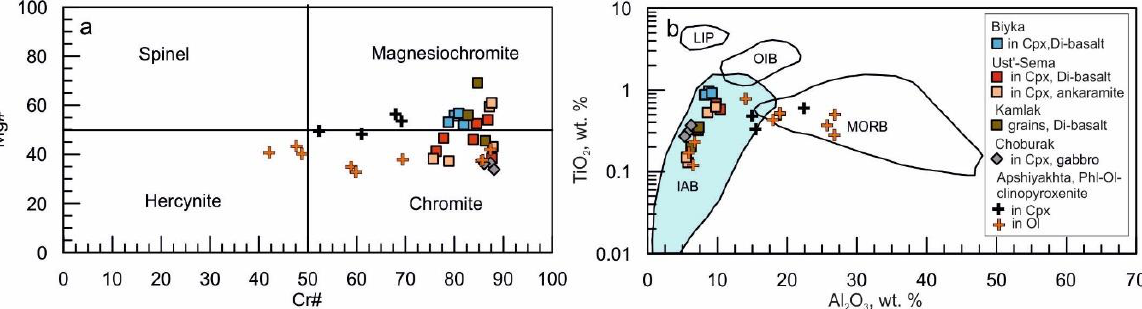
Figure 8. ( a ) Classification diagram for spinels [29]; ( b ) Al 2 O 3 versus TiO 2 discrimination diagram for spinels from different tectonic settings [30]. IABs — island-arc basalts; OIBs — ocean island basalts; MORBs — mid-ocean ridge basalts; LIPs — basalts of large igneous provinces. Cr-spinel from Apshiyakhta phlogopite – olivine clinopyroxenite had a diverse com- position and was represented by chromite, magnesiochromite, and hercynite (Figure 8a). Inclusions of Cr-spinel in clinopyroxenes in these rocks had a relatively low Cr# 52.3 – 69.2 and a high Mg# 48.3 – 56.4 versus Cr# 42.1 – 87.4 and Mg# 32.8 – 43.4 for inclusions in olivine (Table 5). The TiO 2 content of Cr-spinel inclusions varied from 0.33 – 0.60 wt.% in clinopy- roxenes to 0.12 – 0.78 wt.% in olivine (Table 5). The Al 2 O 3 content reached up to 26.81 wt.% (Figure 8b; Table 5). The points of the Cr-spinel compositions from the volcanic rocks of the Ust’ -Sema Formation and the Choburak gabbro fall into the field of island arc systems, whereas the Cr-spinel from phlogopite – olivine clinopyroxenite of the Apshiyakhta intru- sion were shifted toward the field of mid-ocean ridge assemblages (Figure 8b). Magnetite is common as inclusions (10 – 200 µm) in the cores of clinopyroxene pheno- crysts in the Ust’ -Sema Formation volcanics. Rarely it occurs as microcrystals (50 – 300 µm) in the groundmass in the ankaramites of the Anos-Emurla volcanic edifice (Table 5). Table 5. Major element composition (by SEM-EDS) of Cr- spinel and magnetite from the Ust’ -Sema Formation and the Barangol Complex rocks, Gorny Altai.